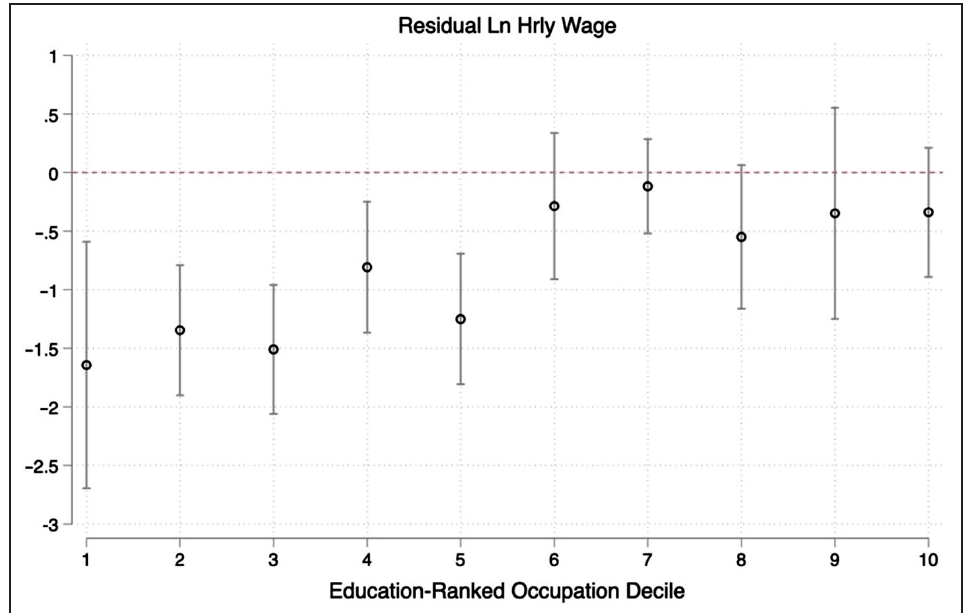
Figure 3 The effect of migration on residual ln(hourly wage) is separately estimated via 2SLS within occupation skill